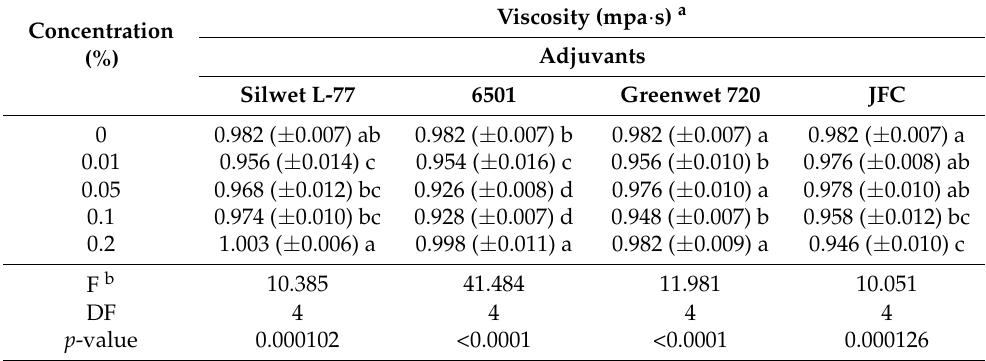
Table 3. Viscosity of bifenthrin diluent mixed with adjuvants in different concentrations.